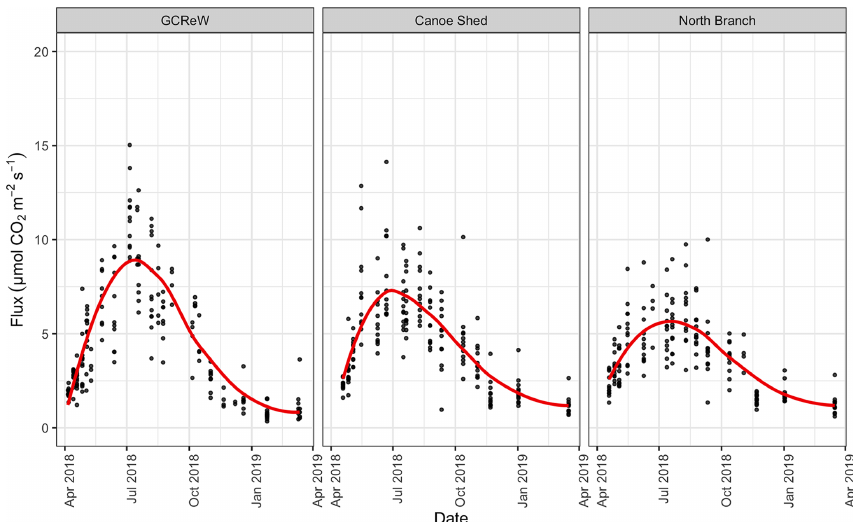
Figure 2. CO 2 flux over time from April 2018 to April 2019 for 36 measurement points across three sites; red line shows the seasonal trend using a loess smoother.